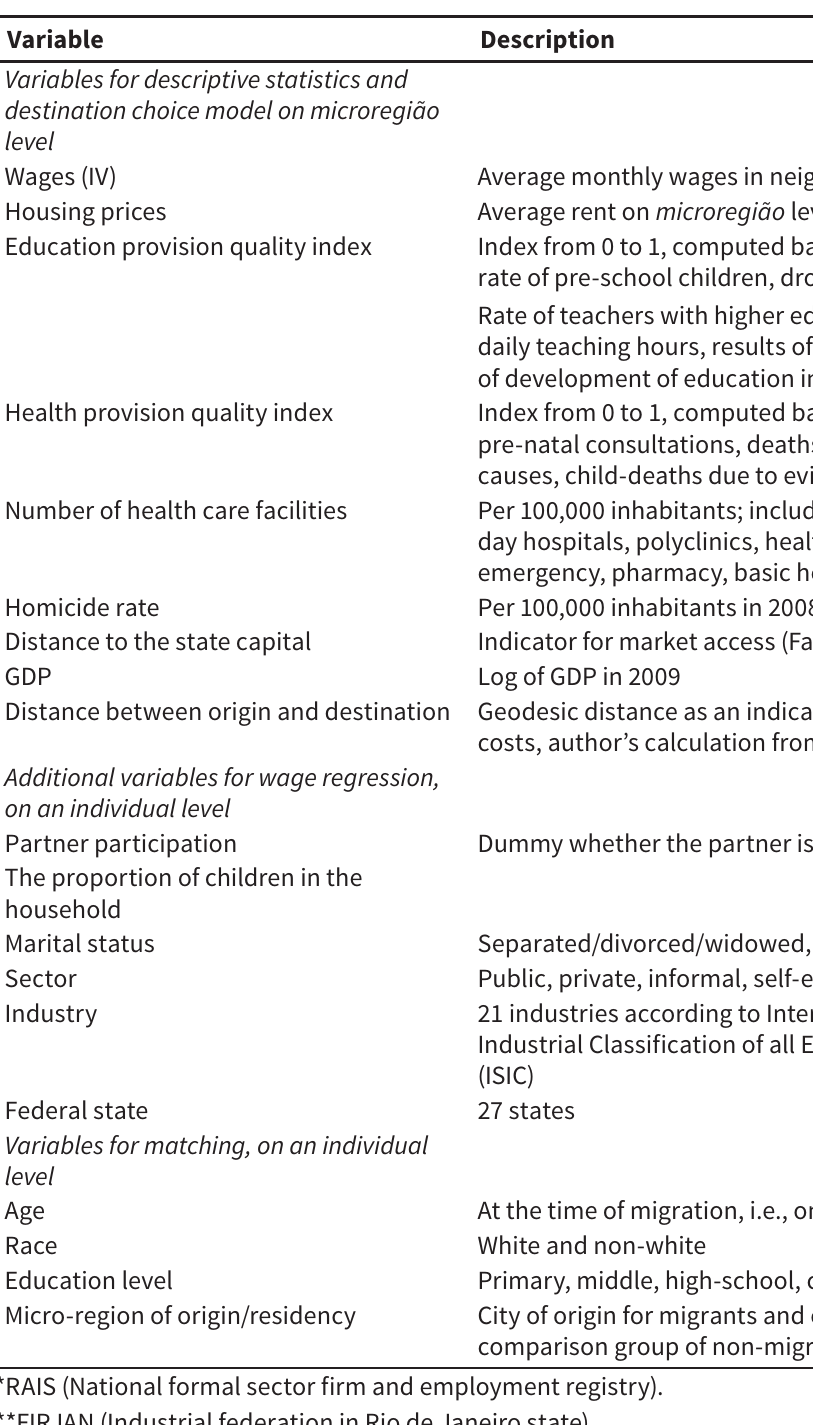
Variables and data